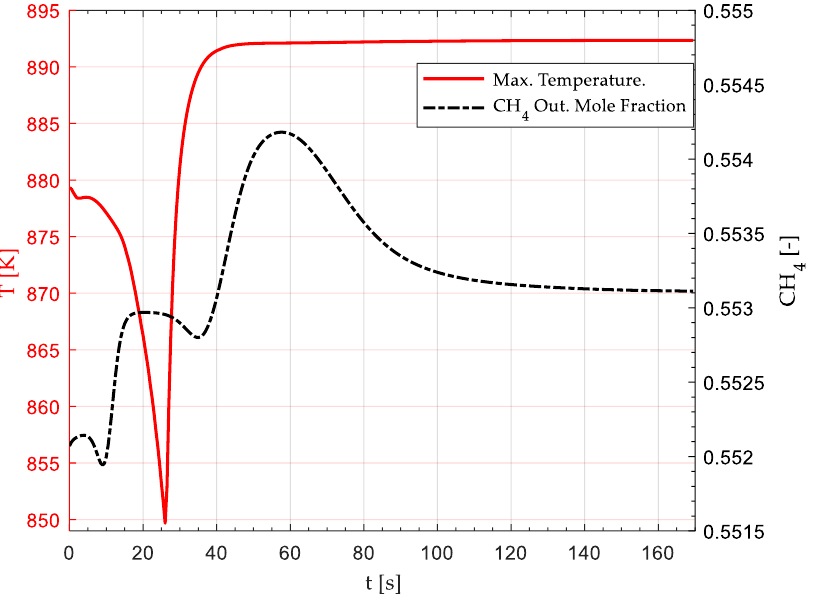
Figure 9. Effect of a 20 K step-rise in the feed gas (523 K to 543 K) on the maximum (Hot Spot) reactor temperature and CH 4 average outlet mole fraction. The disruption begins at t = 0, and a new steady state is established after t ≈ 120 s.